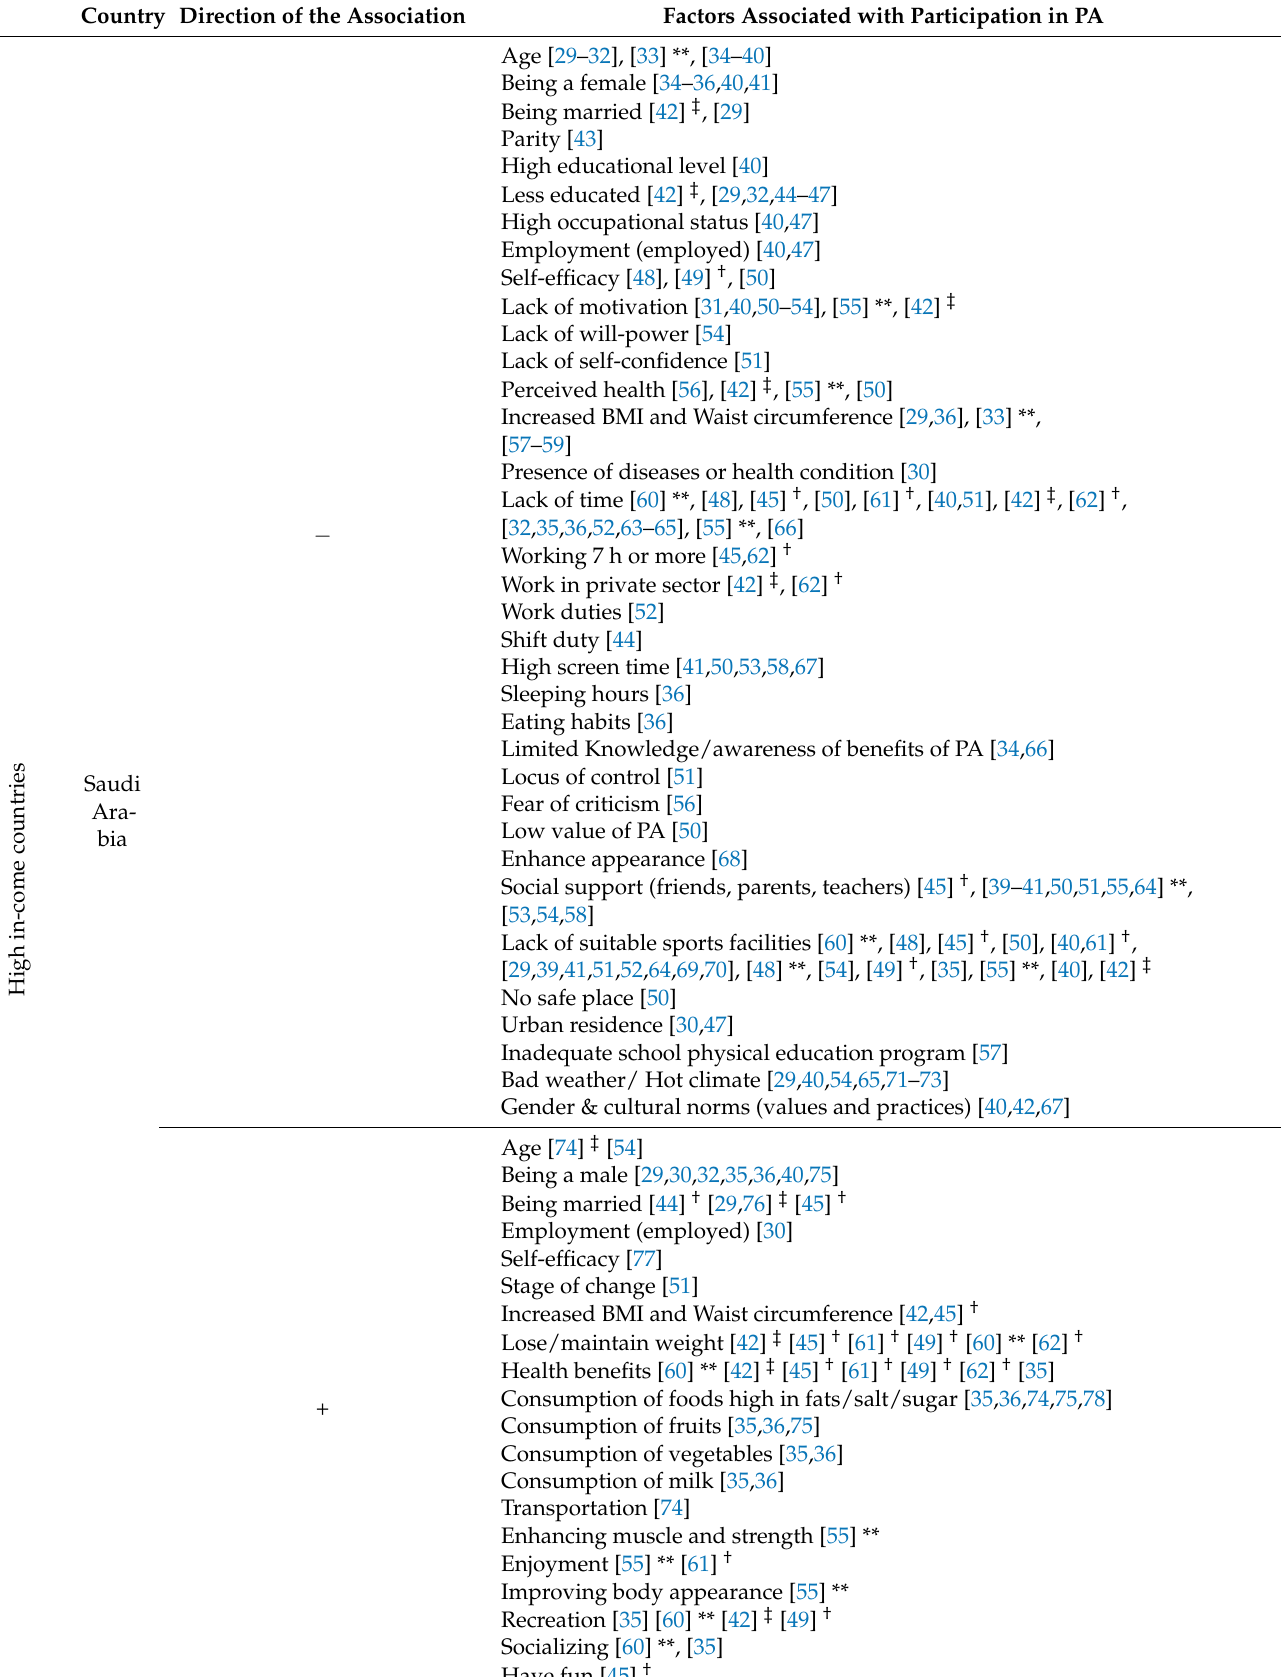
Table 2. Factors (barriers and facilitators) associated with physical activity in MENA. Country Direction of the